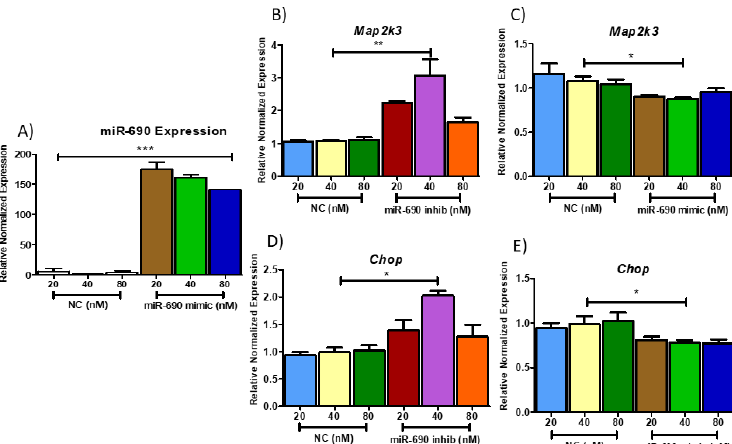
Figure 5. Regulatory role of different concentrations of miR ‐ 690 on its targets. ( A ) miR ‐ 690 transfection validation. All 3 different concentrations (20–80 nM) of miR ‐ 690 mimic ‐ treated groups showed significantly higher miR ‐ 690 expression compared to negative controls (NC). ( B ) Potential target of miR ‐ 690, mitogen activated protein kinase kinase 3 ( Map2k3 ) showed significantly higher expression with 40nM inhibitor compared to NC groups. ( C ) The 40 nM mimic concentration showed significantly reduced Map2k3 expression compared to 40 nM NC. (D) C/EBP homologous protein ( Chop ) showed significantly higher expression with 40nM inhibitor compared to NC groups and (E) 40 nM mimic concentration showed significantly reduced Chop expression compared to 40 nM NC. Data are presented as mean ± SEM (*** p < 0.0001, ** p <0.001, * p < 0.05). ( n = 3). To confirm the regulatory effects of miR ‐ 690 on selected genes ( Map2k3, Map3k7, Mapk14, Hdac4, Atf6 ), differentiated 3T3 ‐ L1 adipocytes were transfected with miR ‐ 690 mimic, inhibitor and NC. As indicated in Figure 6, miR ‐ 690 inhibitor significantly upregulated expression of Map3k7 and Map2k3 compared to their respective NC groups (Figure 6A–B). In contrast, miR ‐ 690 mimic ‐ treated groups showed significantly reduced Map3k7 and Map2k3 expression (Figure 6A,B). Another MAPKs, Mapk14/p38, did not show significant changes with either miR ‐ 690 mimic or inhibitor treatments compared to NC, although it was identified as a possible target of miR ‐ 690 from bioinformatic analysis. However, Hdac4 and Atf6 exhibited significantly high mRNA levels in miR ‐ 690 inhibitor treated groups (p < 0.05); however, miR ‐ 690 mimic did not show the expected reduction compared to the NC group (Figure 6D,E).